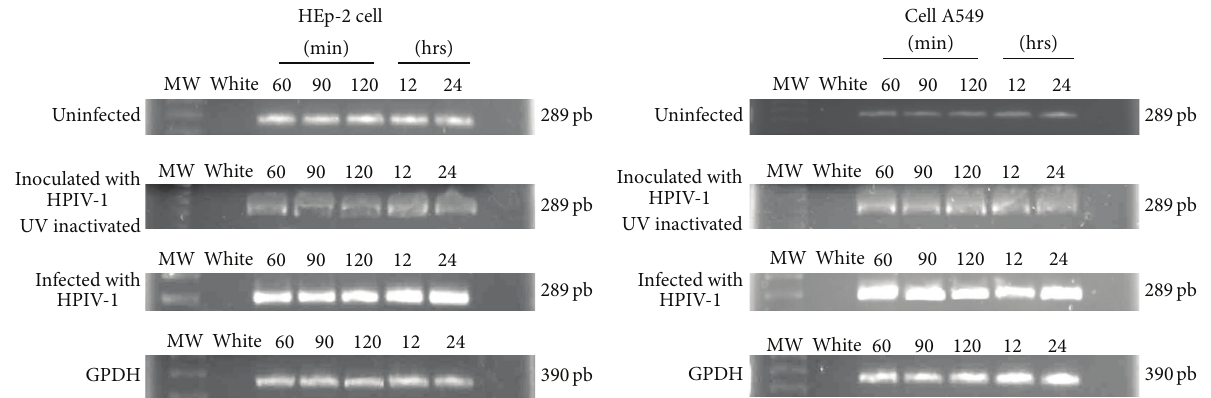
Figure 3: IL8 expression by RT-PCR analysis in HEp2 and A549 cells infected, uninfected, and the HPVI-1 inactive. The enhanced expression of IL8 was given in infected cells HPVI-1. GAPDH expression was not different by infection.